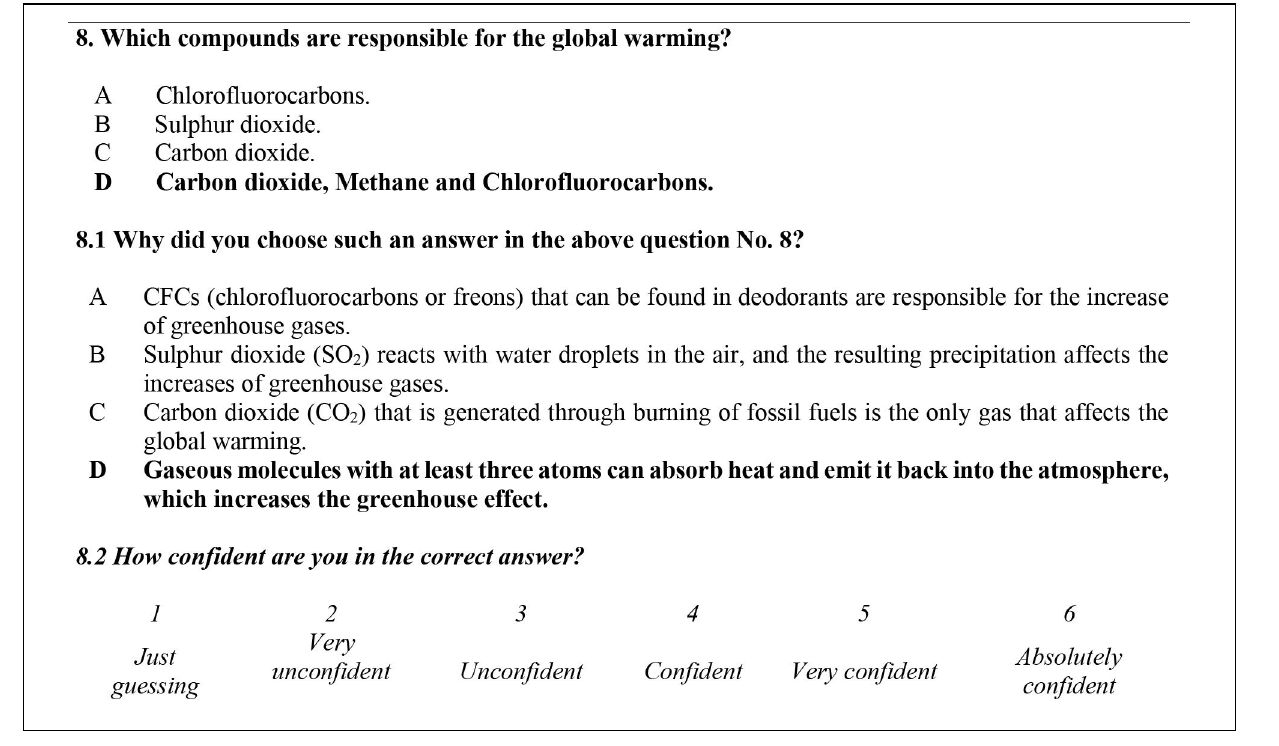
Figure 1. An example of the task no. 8 in APPDiT; 1 st tier (8), 2 nd tier (8.1); 3 rd tier (8.2.); the correct answer and the correct reason are presented in